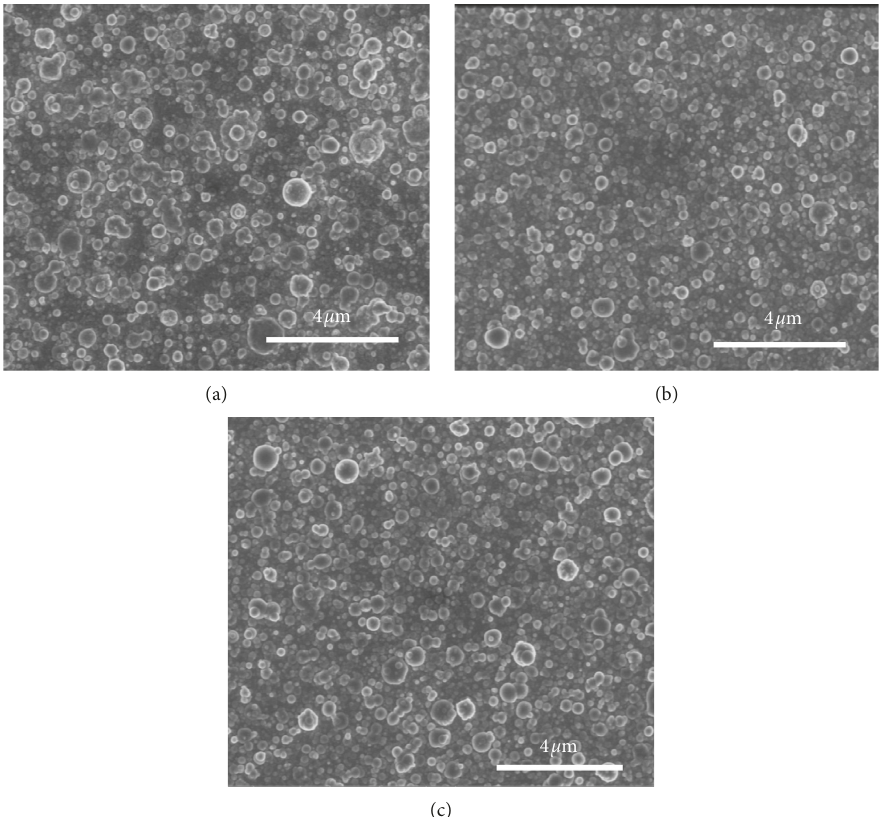
Figure 6: SEM images of LMO thin films deposition at 15kV after annealing at different temperatures (a) as the deposited film: (b) 400 ° C; (c) 800 ° C.